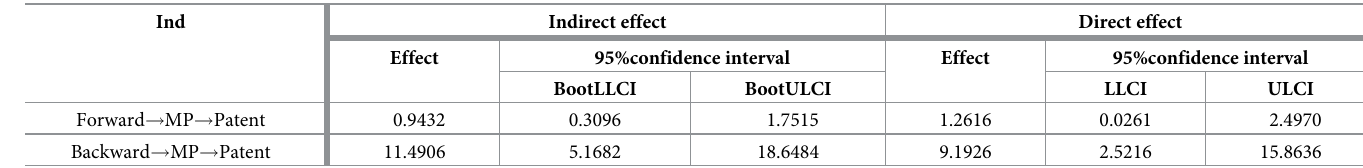
Table 5. Intermediary test of market power.